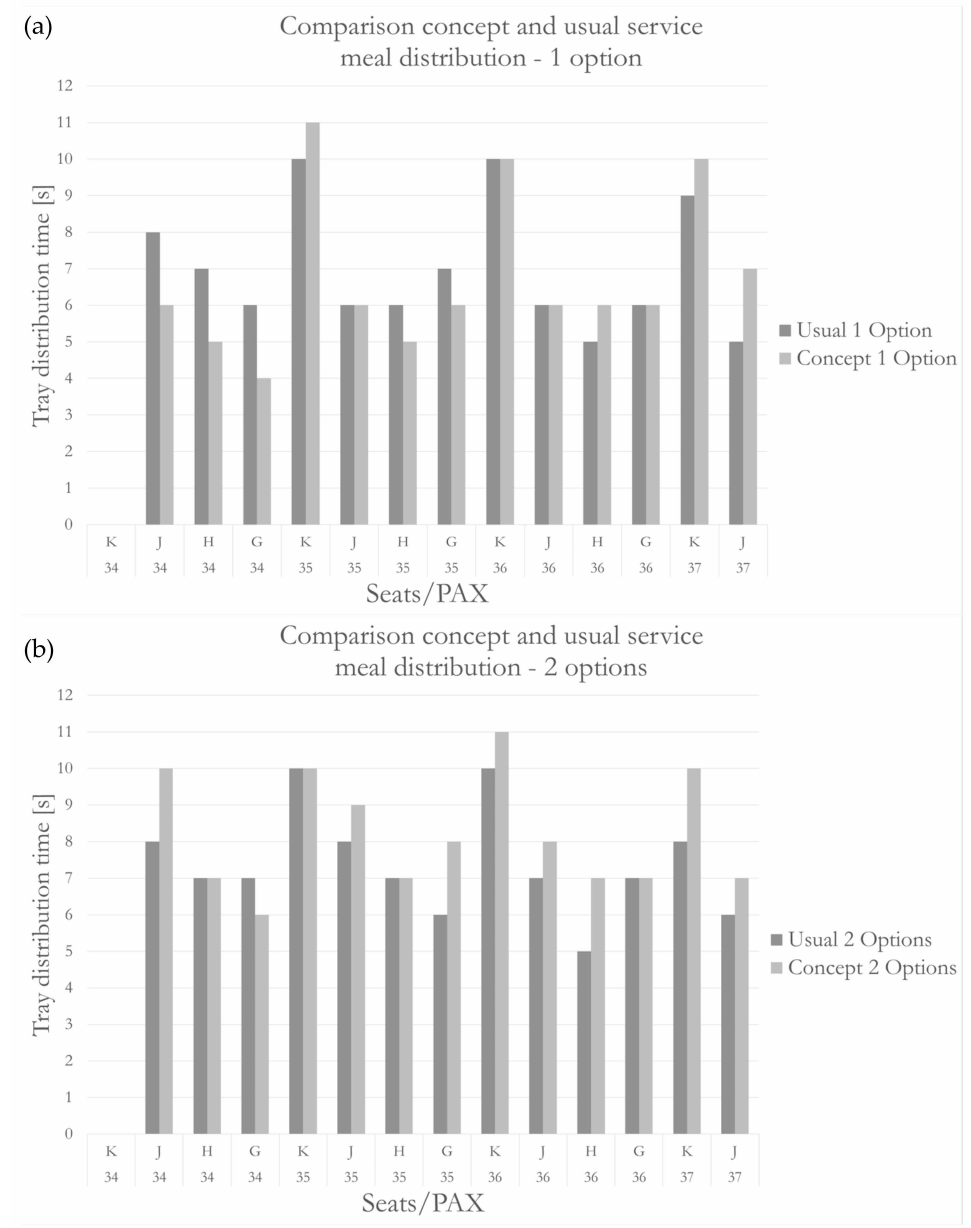
Figure 21. Service time for distribution with ( a ) 1 and ( b ) 2 meal options. Figure 22 shows the results for the service times of tray distribution to each passenger with three or four meal options. Comparison was performed between a standard service and distribution with the new